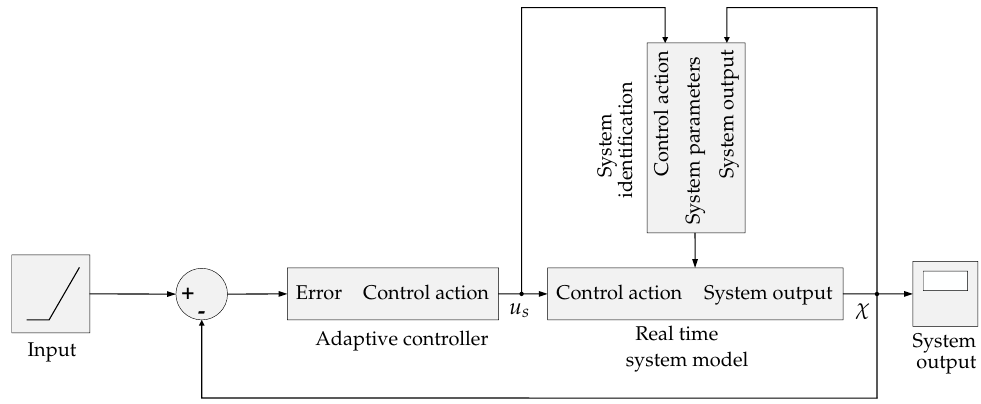
Figure 8. Block diagram of System Identification (SI) algorithm and adaptive control